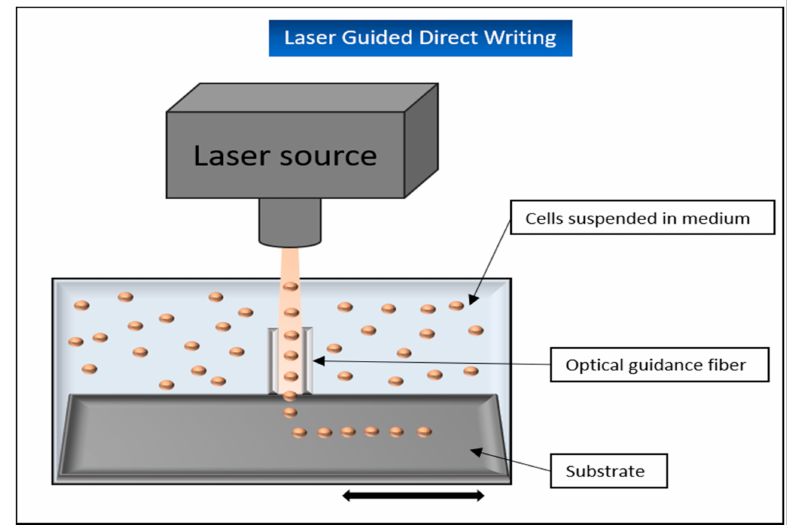
Figure 12. Schematic representation of laser guided direct writing. Cells are directed from a liquid solution onto the substrate using a weak laser